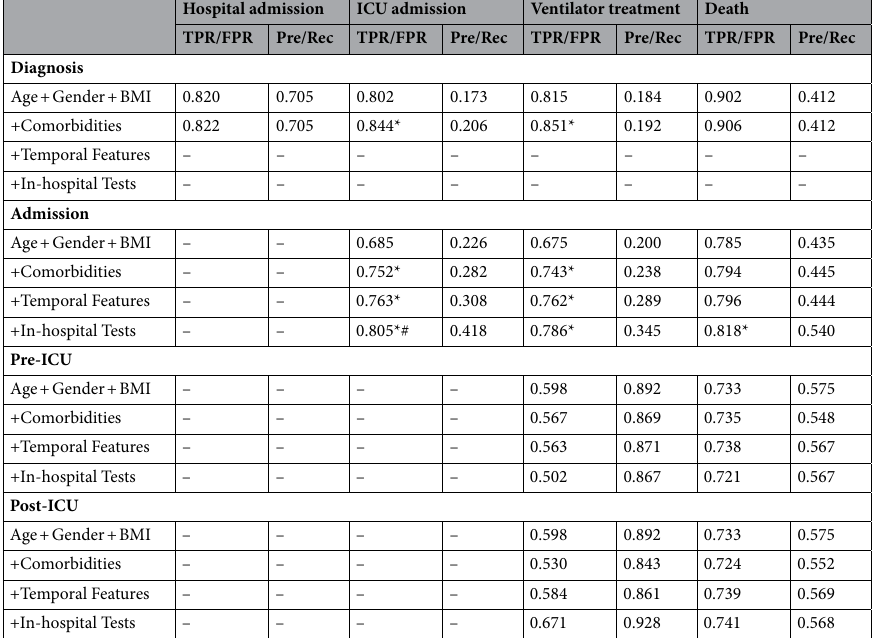
Table S5. When compared to non-hospitalized patients, hospital admitted patients were older and more likely to be male and a number of comorbidities were overrepresented in the admitted subgroup. These included hyperten- sion, diabetes, ischemic heart disease, heart failure, arrythmias, stroke, chronic obstructive pulmonary disease (COPD) or asthma, osteoporosis, neurological disease, cancer, chronic kidney failure and use of dialysis. Hos- pitalized patients were more likely to be smokers (Table 2). For hospitalized patients requiring ICU admission vs. hospitalized patients without ICU admission, only male sex, Body Mass Index (BMI), dementia and hypertension differed between patients and ICU-admitted patients were furthermore more likely to be smokers, older and male (Table 1). Non-survivors were furthermore more likely to suffer from hypertension, diabetes, ischemic heart disease, heart failure, arrythmias, stroke, COPD or asthma, osteoporosis, dementia, mental disorders, neurological dis- ease, cancer, chronic kidney failure and use of dialysis. When compared to non-admitted, admitted patients differed significantly in all measured values (Table 2). Among those hospitalised, those admitted to the ICU had derangements in many variables (Table 2). The same was observed for non-survivors compared with survivors (Table 2). ML models prediction. ML models are presented in Table 3 and graphically depicted in supplementary Fig. S1 (Diagnosis model), Supplementary Fig. S2 (Admission model), Supplementary Fig. S3 (Pre-ICU model) and Supplementary Fig. S4 (Post-ICU model). Base models deployed on the time of diagnosis were able to predict hospital admission with a ROC-AUC of 0.820, ICU admission 0.802, ventilator treatment 0.815 and death 0.902 (Table 3 and Supplementary Fig. S1). Adding information on patient comorbidities increased the predictive ability for all outcomes. Models deployed at hospital admission achieved ROC-AUC scores ranging from 0.675 to 0.818 for the selected outcomes (Table 3 and Supplementary Fig. S2). Adding information on comorbidities, temporal features